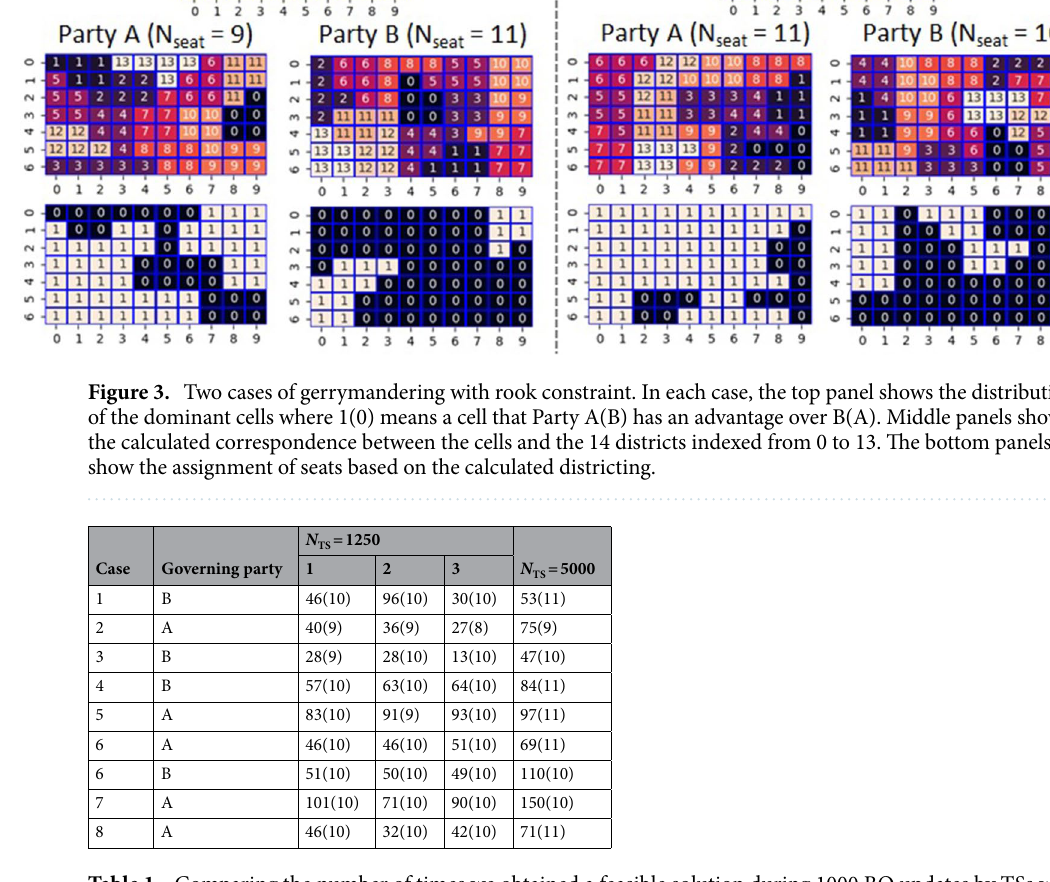
Table 1. Comparing the number of times we obtained a feasible solution during 1000 BO updates by TSs with 1250 or 5000 trials. The number in parentheses indicates the number of seats assigned ( N seat ). The TS with 1250 trials was run three times with different random number seeds for the initial